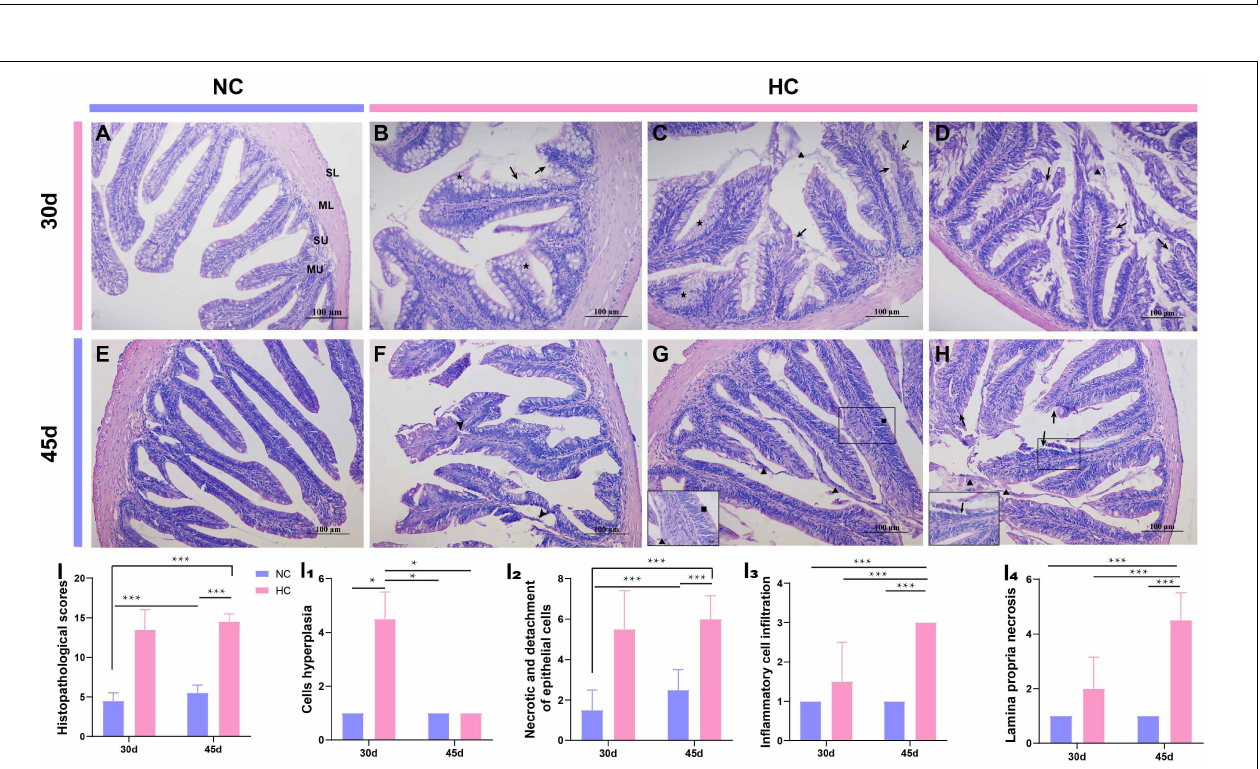
FIGURE 4 | Histopathological observations of the largemouth bass intestine (H&E staining) (A) The intestines of the NC-fed fish were undamaged at 30 days, with an intact mucous layer (MU), submucosal layer (SU), muscle layer (ML), and serosa layer (SL); (B–D) Proliferation of mucus cells (pentagram), increased mucus secretion (triangles), and loss of epithelial cells were detected in the intestines of fish fed the HC diet for 30 days (arrow); (E) The intestines of NC-fed fish at 45 days; (F–H) the intestines of fish fed the HC diet for 45 days; intestinal villi broken (arrowhead), mucus secreted (triangles), and epithelial cells shed (arrow), respectively; (I) Total intestinal histopathological score; (I 1 –I 4 ) the histopathological scores for cell hyperplasia, necrosis, and detachment of epithelial cells, inflammatory cell infiltration, and necrosis of the lamina propria, respectively (* P < 0.05, *** P < 0.001. NC: 0% α -starch diet, HC: 22% α -starch diet).